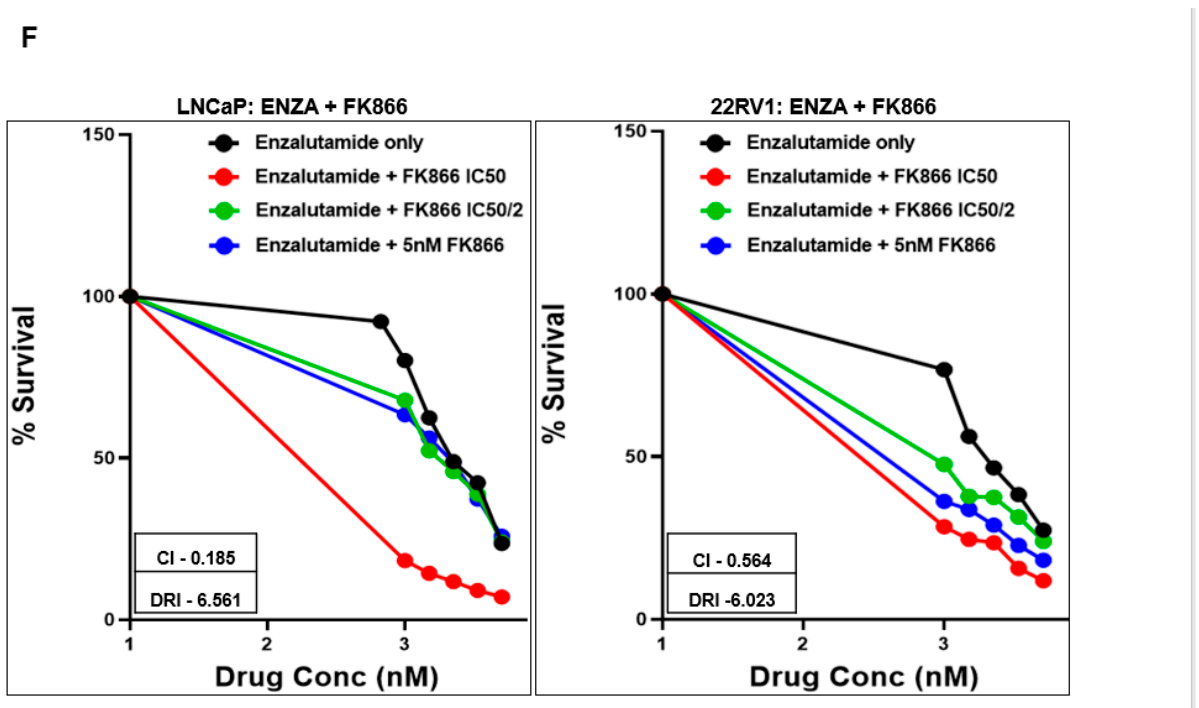
Figure 3. Dose-response curves representing in vitro cytotoxicity of the FK866 drug combination in metastatic PCa cell lines. ( A – D ) In vitro cytotoxicity was assessed using MTT or 4,5-Dimethylthiazol-2-yl)-2,5-diphenyltetrazolium bromide assay following treatment with single-agent DTX or single-agent FK866 at increasing concentrations or increasing concentrations of DTX in combination with fixed (5 nM) concentration of FK866. ( A ) AR lo mCRPC cell lines PC-3, DU145, ( B ) Acquired taxane-resistant mCRPC lines DUTXR and PC3-TXR, (C) clonally derived metastatic (PC3M), and the AR-independent (C42B) PCa lines; ( D ) AR high mCSPC lines LnCAP and 22Rv1. ( E ) CI values representing synergy between FK866 and TX in metastatic PCa lines (mCRPC lines, mCSPC lines, and Clonally derived mCRPC lines). Combination Index (CI) and Dose reduction (DRI) values were calculated according to Chou-Talalay’s method. CI values between 0.9–0.3 and 0.3–0.1 signify synergism and strong synergism, respectively, between the drugs treated in combination. ( F ) Dose-response plots showing FK866 in combination with the androgen receptor inhibitor Enzalutamide combination in metastatic PCa cell lines.